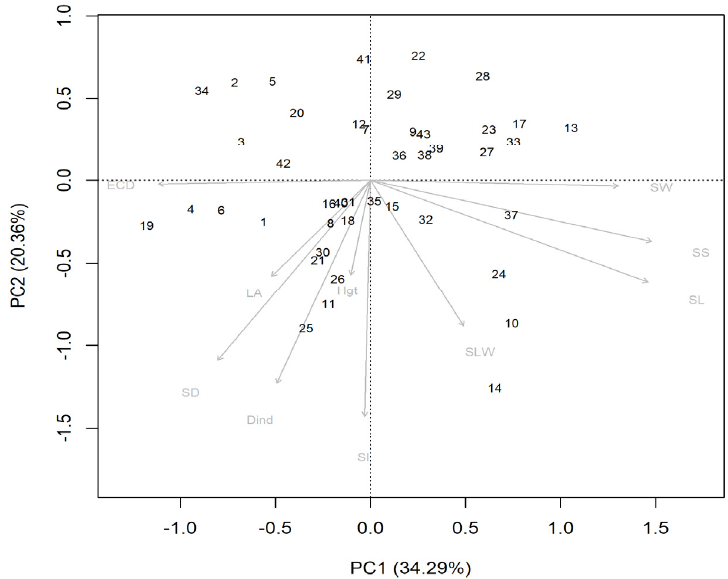
Figure 5. Principal components analysis considering eight leaf anatomical variables and three bio- metric characteristics of 43 Coffea canephora genotypes. biometric characteristics of 43 Coffea canephora